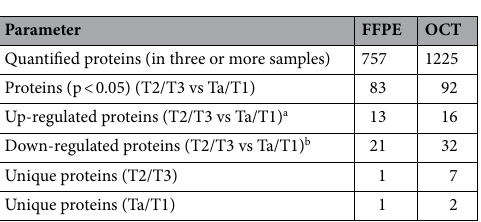
Parameter FFPE OCT Quantified proteins (in three or more samples) 757 1225 Proteins (p < 0.05) (T2/T3 vs